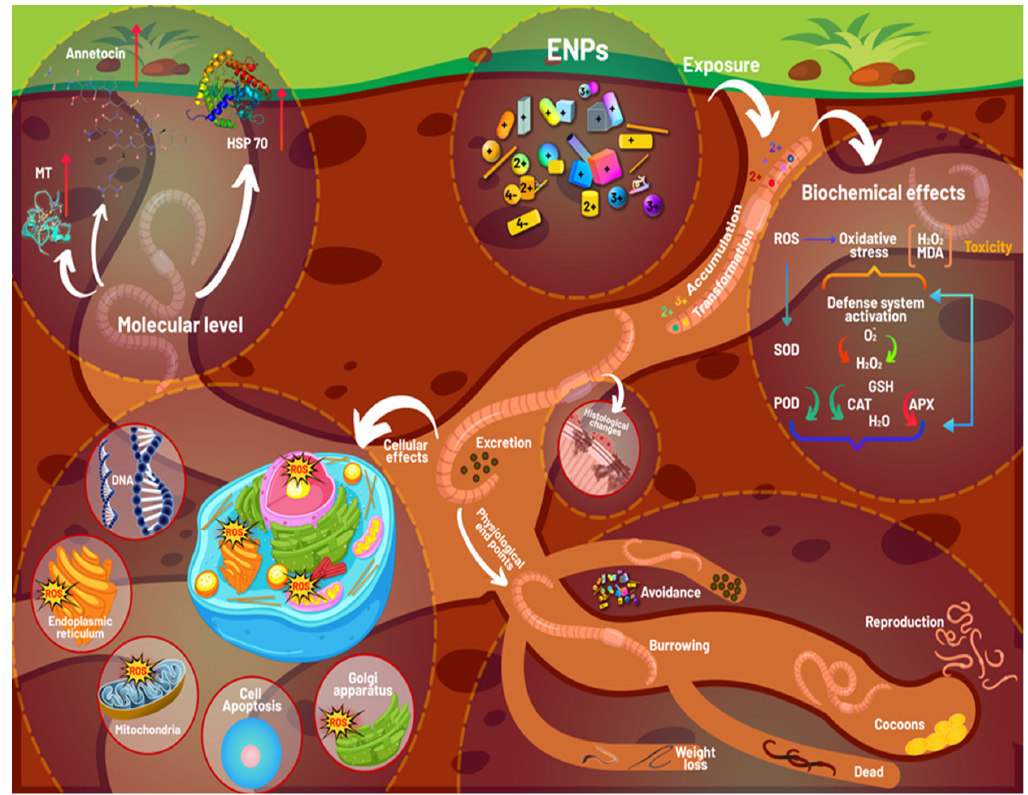
Figure 3. Toxic effects of manufactured nano ‐ objects (MNOs) on